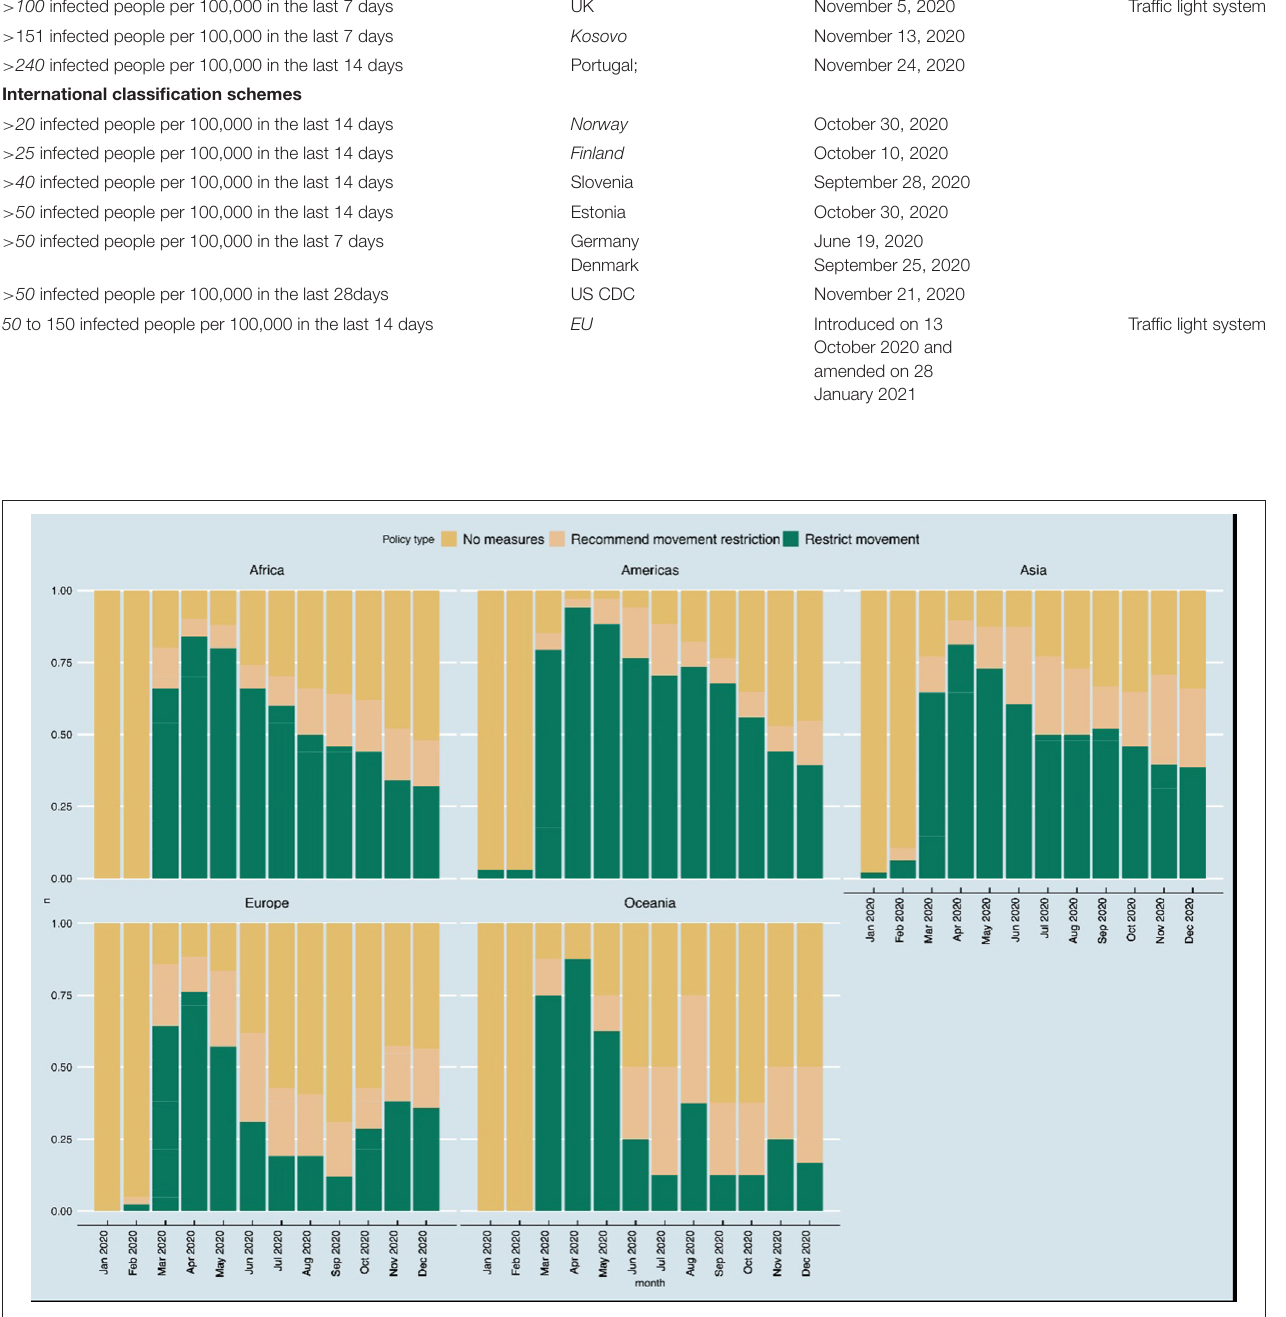
FIGURE 2 | Trends in restrictions on internal